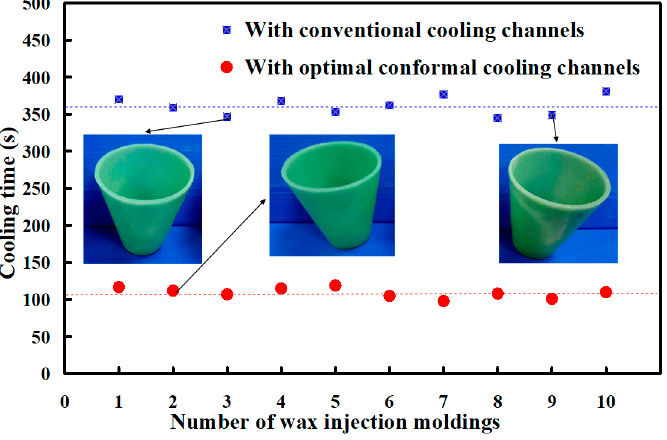
Figure 19. The cooling time for the ten injection moldings in the low-pressure wax injection mold- ing process.